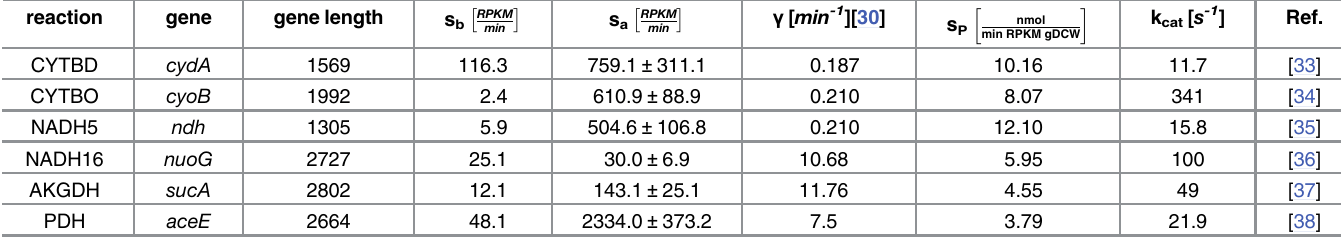
Table 1. Parameters for dddFBA